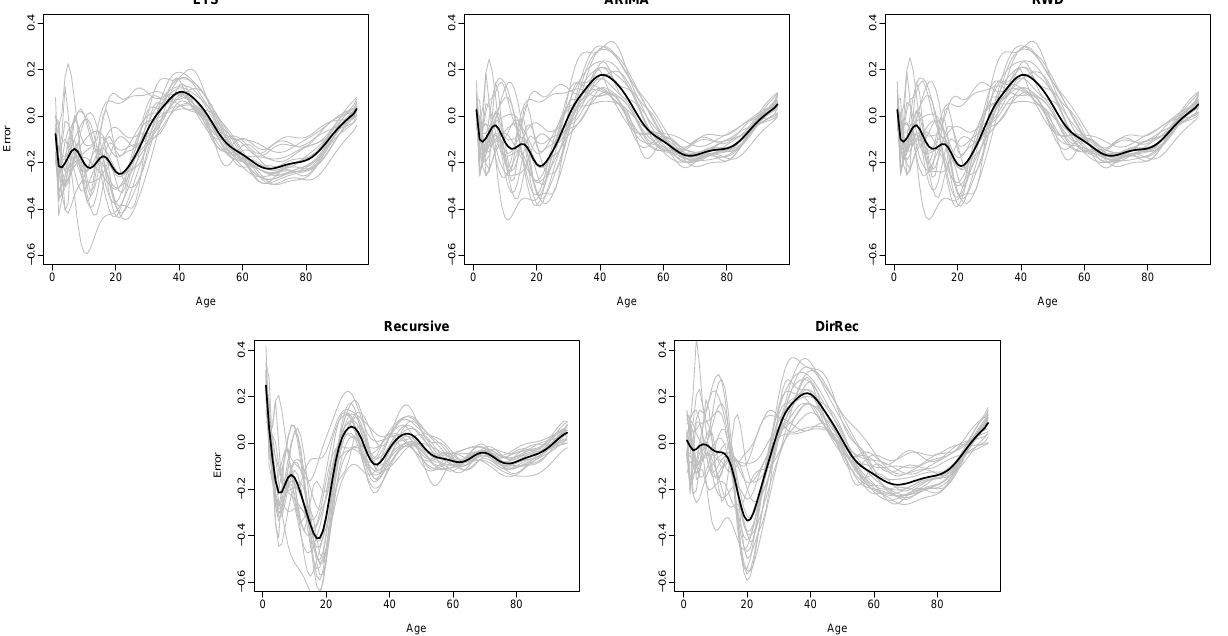
Figure 4. Plots of the 20-step-ahead forecast errors functions (gray lines denote the error functions and black lines denote the mean of the forecast error functions) were obtained by all the methods for the log mortality dataset of Australia (female).